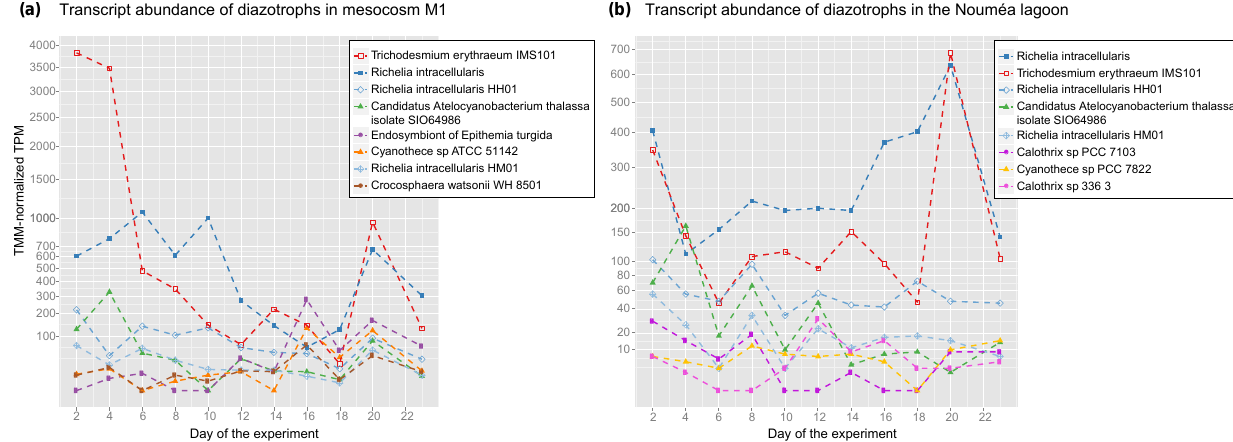
Figure 5. Gene expression in putative diazotrophic cyanobacteria inside M1 and in the Nouméa lagoon. Note the square-root scale for both plots and the generally higher transcript abundances inside M1. Transcriptional activity is presented in TPM (transcripts per million transcripts sequenced), normalized in between samples by TMM normalization (edgeR). Thus, plots can be directly compared, but values are